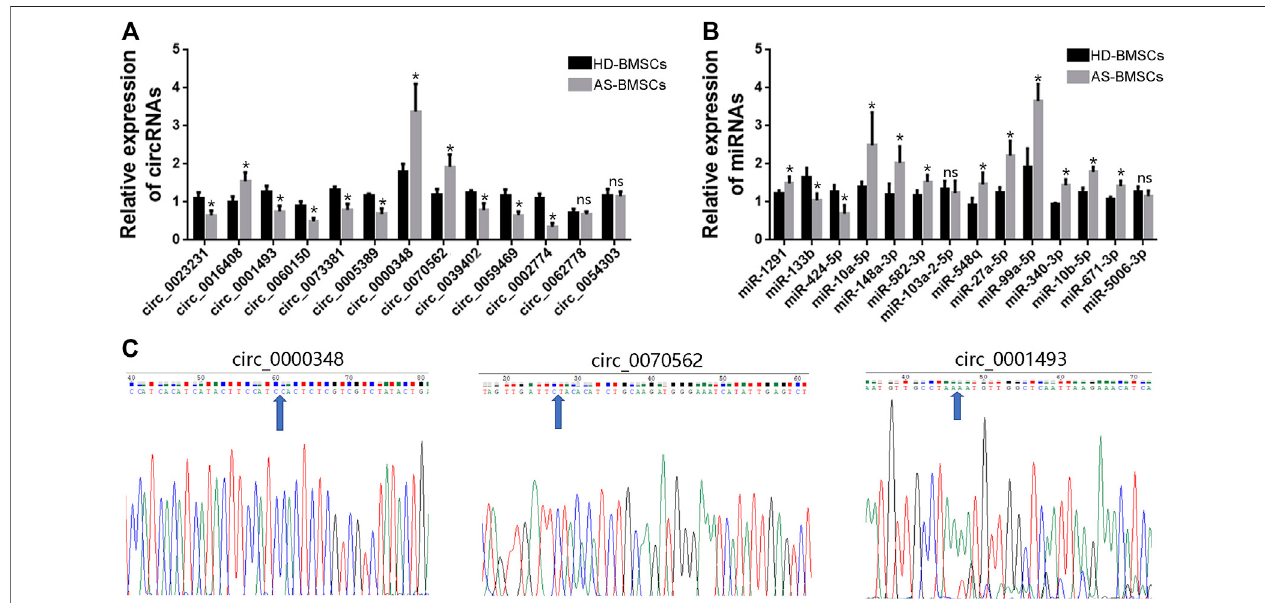
FIGURE6| qRT-PCRvalidationofDEcircRNAsandmiRNAs. (A) .TherelativeexpressionlevelsofcircRNAsinvolvedinTGF-betasignalingpathway(theindicated circRNAs with black arrows) in 10 pairs of AS-BMSCs and HD-BMSCs. (B) . The relative expression levels of miRNAs selected from the DE miRNAs in 10 pairs of AS- BMSCsandHD-BMSCs.Dataarepresentedasthemeans±SEM.* p < 0.05.ns:notsigni fi cant.N=10BMSCspergroup. (C) .Sangersequencingcon fi rmedtheback- splice junction sites of circ_0000348, circ_0070562 and circ_0001493. Blue arrowheads indicated the junction